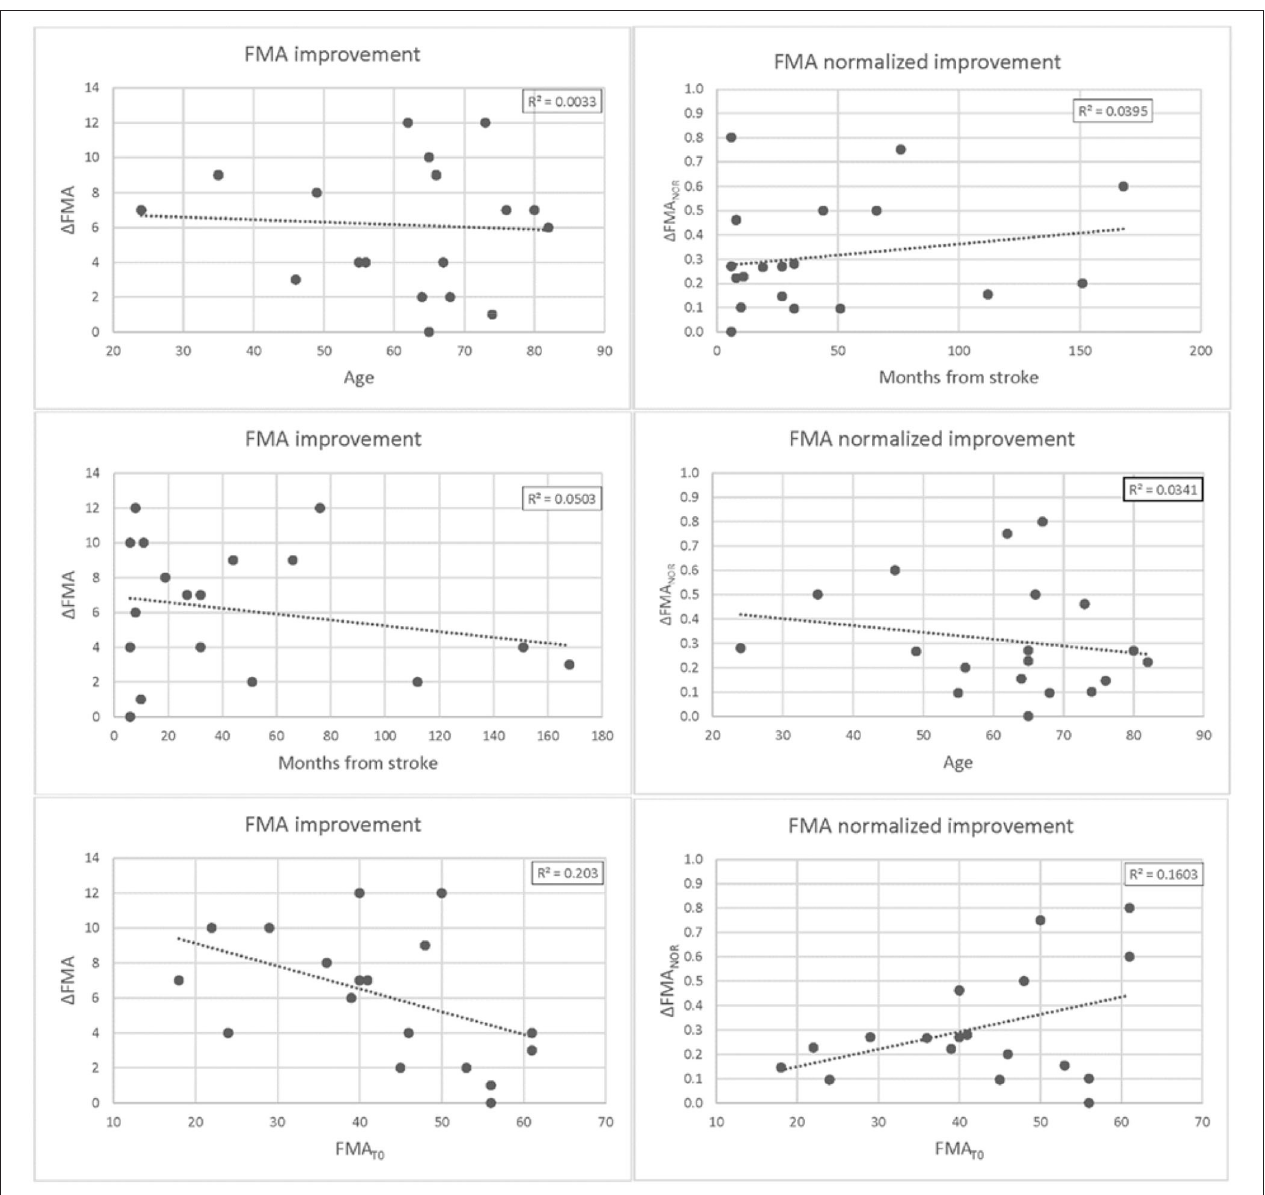
FIGURE 4 | Differences in Fugl-Meyer Assessment (FMA) at T1 vs. T0 plotted against patients’ age ( upper panel), months from stroke ( middle panel), and FMA scores at baseline. Differences are expressed as absolute values 1 FMA = FMAT1 -FMAT0 ( left panel) and potential recovery 1 FMANOR = 1 FMA/(66-FMAT0) ( right panel). For each plot, the linear regression curve along with the r-squared value is also shown.